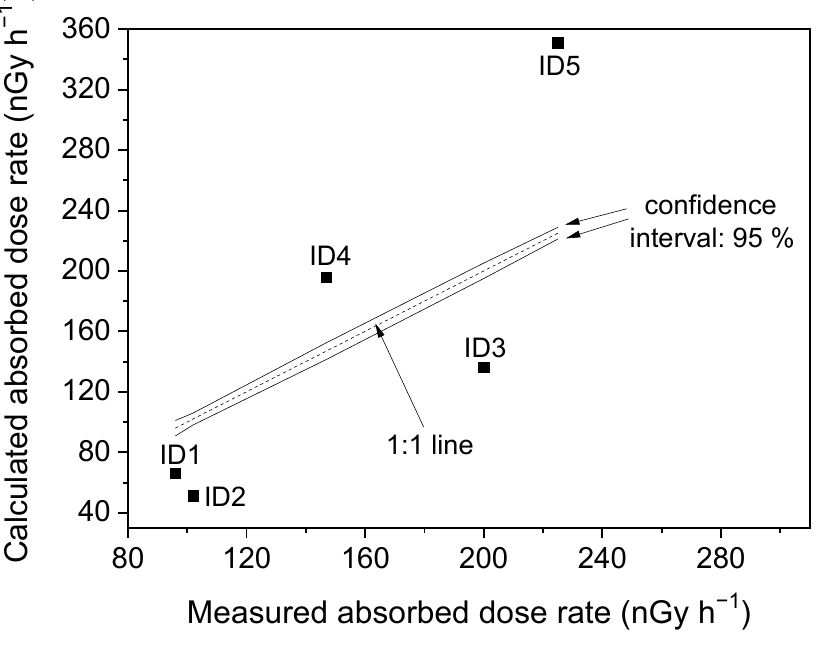
Figure 2. A comparison between calculated and measured absorbed dose rate. This is not surprising, considering that no good agreement between calculated and measured gamma-ray activity is usually found in the literature [57], due to the fact that measured values may be influenced by soil moisture, wash-out of dust containing radon decay products, and principally by radionuclide inhomogeneity in the soil.